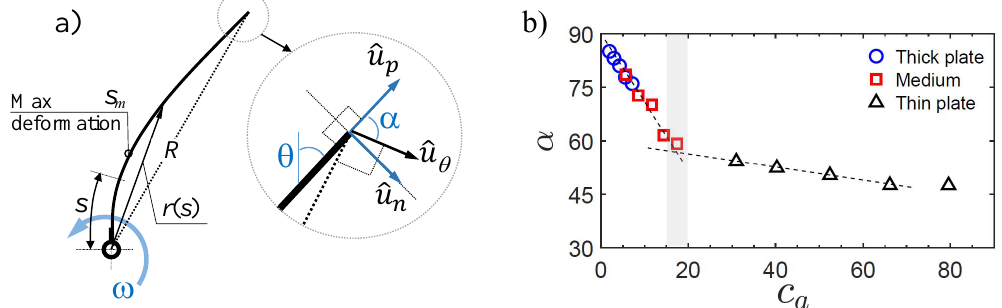
Figure 4. ( a ) Definition of basic parameters characterizing the plates reconfiguration; and ( b ) relative angle α between the tangential and flow directions in the vicinity of the tip the as a function of Ca